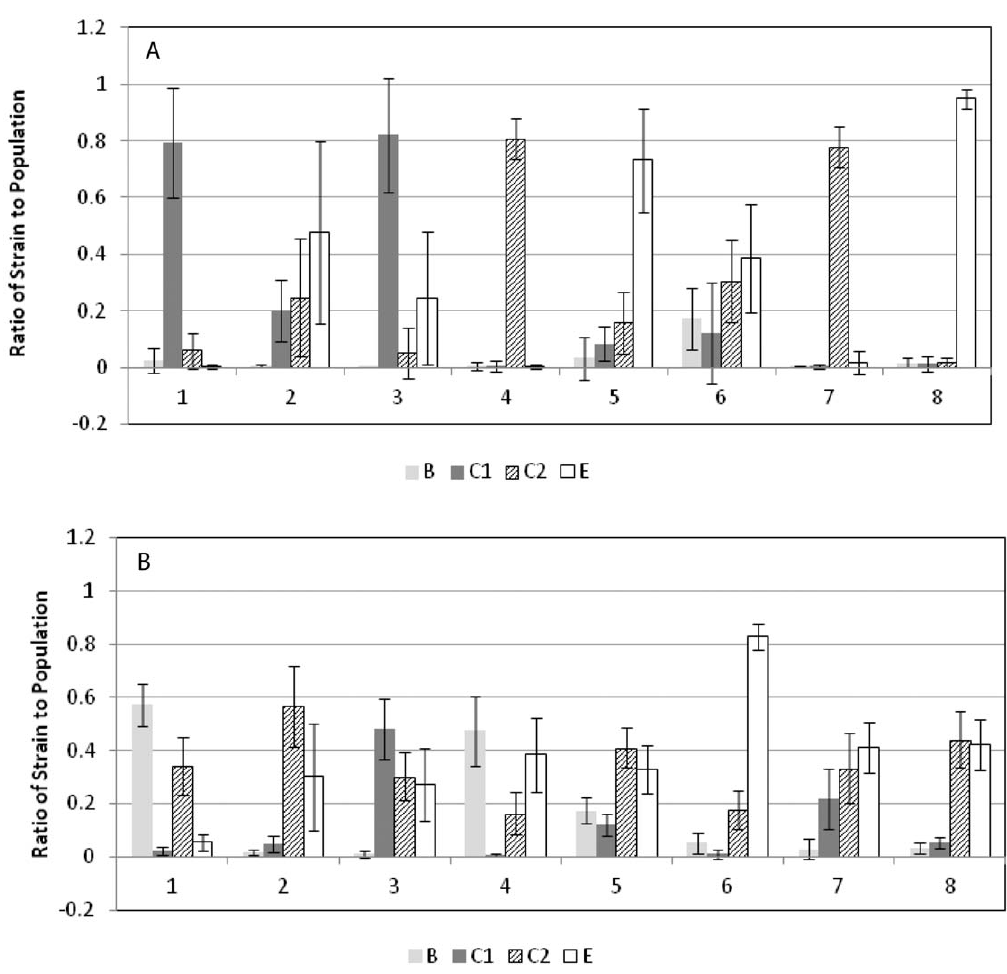
Figure 2. Ratio of each strain of Salmonella in the Salmonella + fecal bacteria enrichments to the whole Salmonella population. (A) Ratios from enrichments using RV and plated onto XLD; (B) Ratios from enrichments using RVS and plated onto XLD. Values are the averages of all replicates from multiple experiments, and the error bars represent standard deviation.